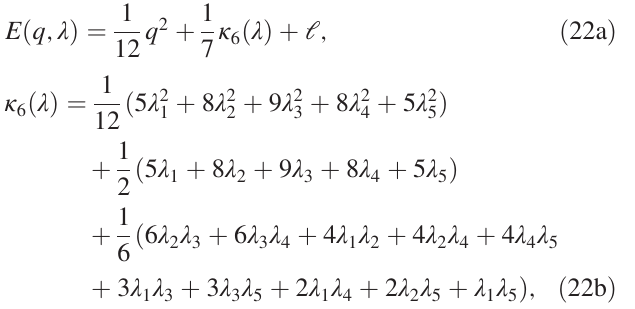
TABLE IV. Fusion table for flavor screening at the FL fixed point of the SU(6) Kondo model. The table has the same structure as the left and center parts of Table II, but here the free bath excitations are labeled ð q; λ Þ , their energies are computed using Eqs. (22) and Table S4 of the SM [54], and flavor fusion with is performed using SU ð 6 Þ 1 fusion rules (listed in Table S5 of the SM [54]). The resulting multiplets ð q; λ 0 Þ have eigenenergies E 0 ¼ E ð q; λ 0 Þ , degeneracies d 0 , and excitation energies δ E 0 ¼ E 0 − E 0 . The FL spectrum, obtained by U ð 1 Þ × min SU ð 6 Þ NRG calculations (Fig. 6) for J U ¼ 0 . 1 , is shown on the right. It has been shifted and rescaled such that the lowest energy is zero and the second-lowest values for E and δ E 0 match. The NRG single-fusion and NRG spectra agree very well (deviations ≲ 1%